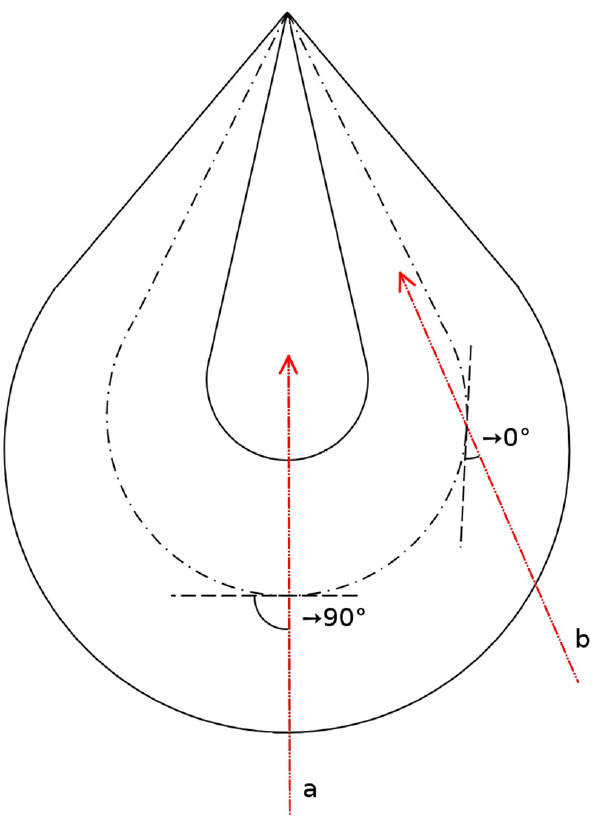
Fig. 6. Schematic representation of the spacecraft trajectory through the flux rope (the global flux rope structure is an adaptation from Burlaga et al., 1990). Trajectory a corresponds to the crossing close to the apex of the flux rope loop. Trajectory b is the crossing through the leg of the flux rope loop. The angle between the local orientation of the invariant axis of the flux rope and the Sun–spacecraft line goes from 90 ◦ for the case a to nearly 0 ◦ for the case b .